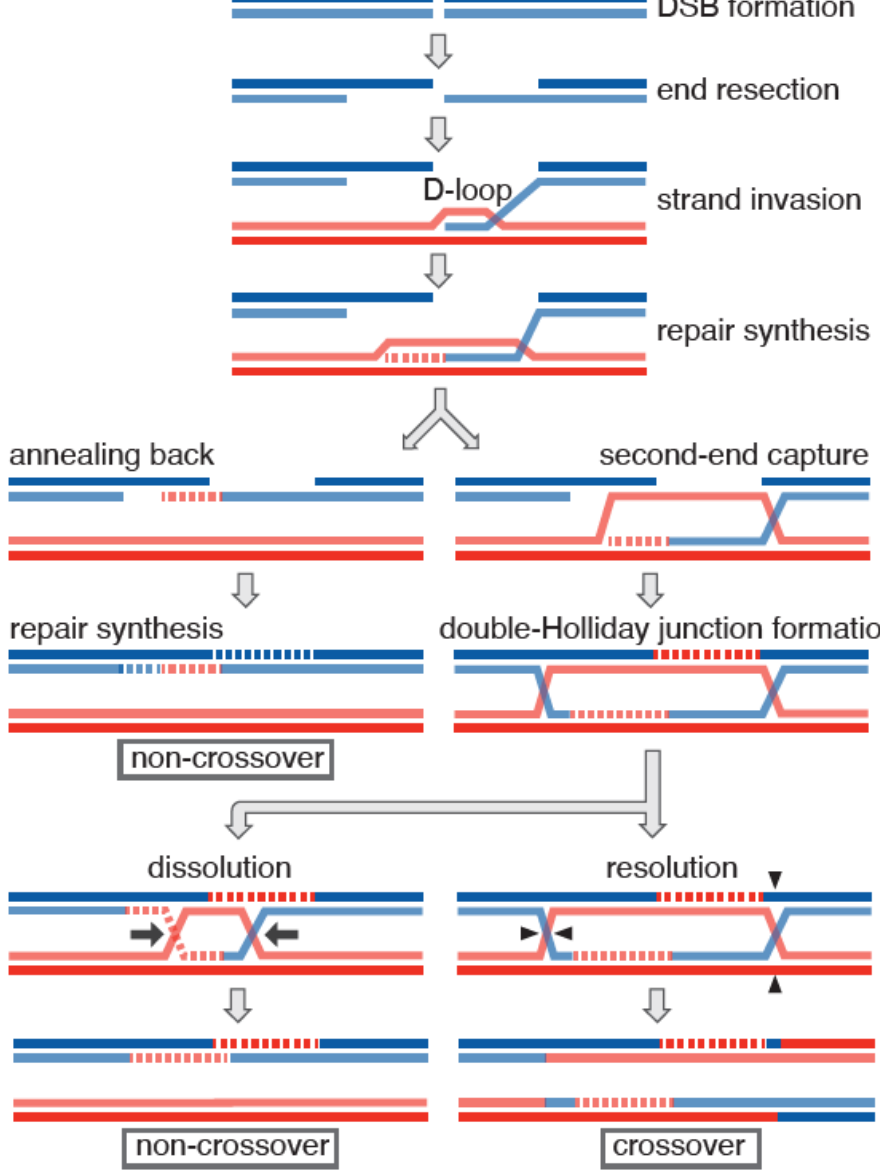
Figure 1. Homologous recombination (HR) steps: The invading 3 ′ -ended ssDNA can anneal to the other end of the DSB, resulting in non-crossovers. Alternatively, annealing of the other DSB end to the displaced strand can lead to the formation of double-Holliday junctions (dHJs). dHJs can be dissolved through either dissolution, forming only non-crossovers, or resolution, forming both crossovers and non-crossovers. These HR pathways could be somewhat oversimplified. Recent studies using budding yeast model locus suggest that both non-crossover and crossover generation during meiosis involves strand annealing with multiple rounds of strand invasion and that branch migration of Holliday junctions is an integral step in crossover formation [3,4].